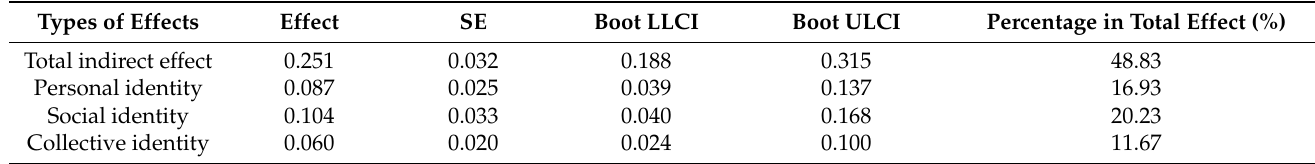
Table 4. Bootstrap analysis of identity as a mediator.